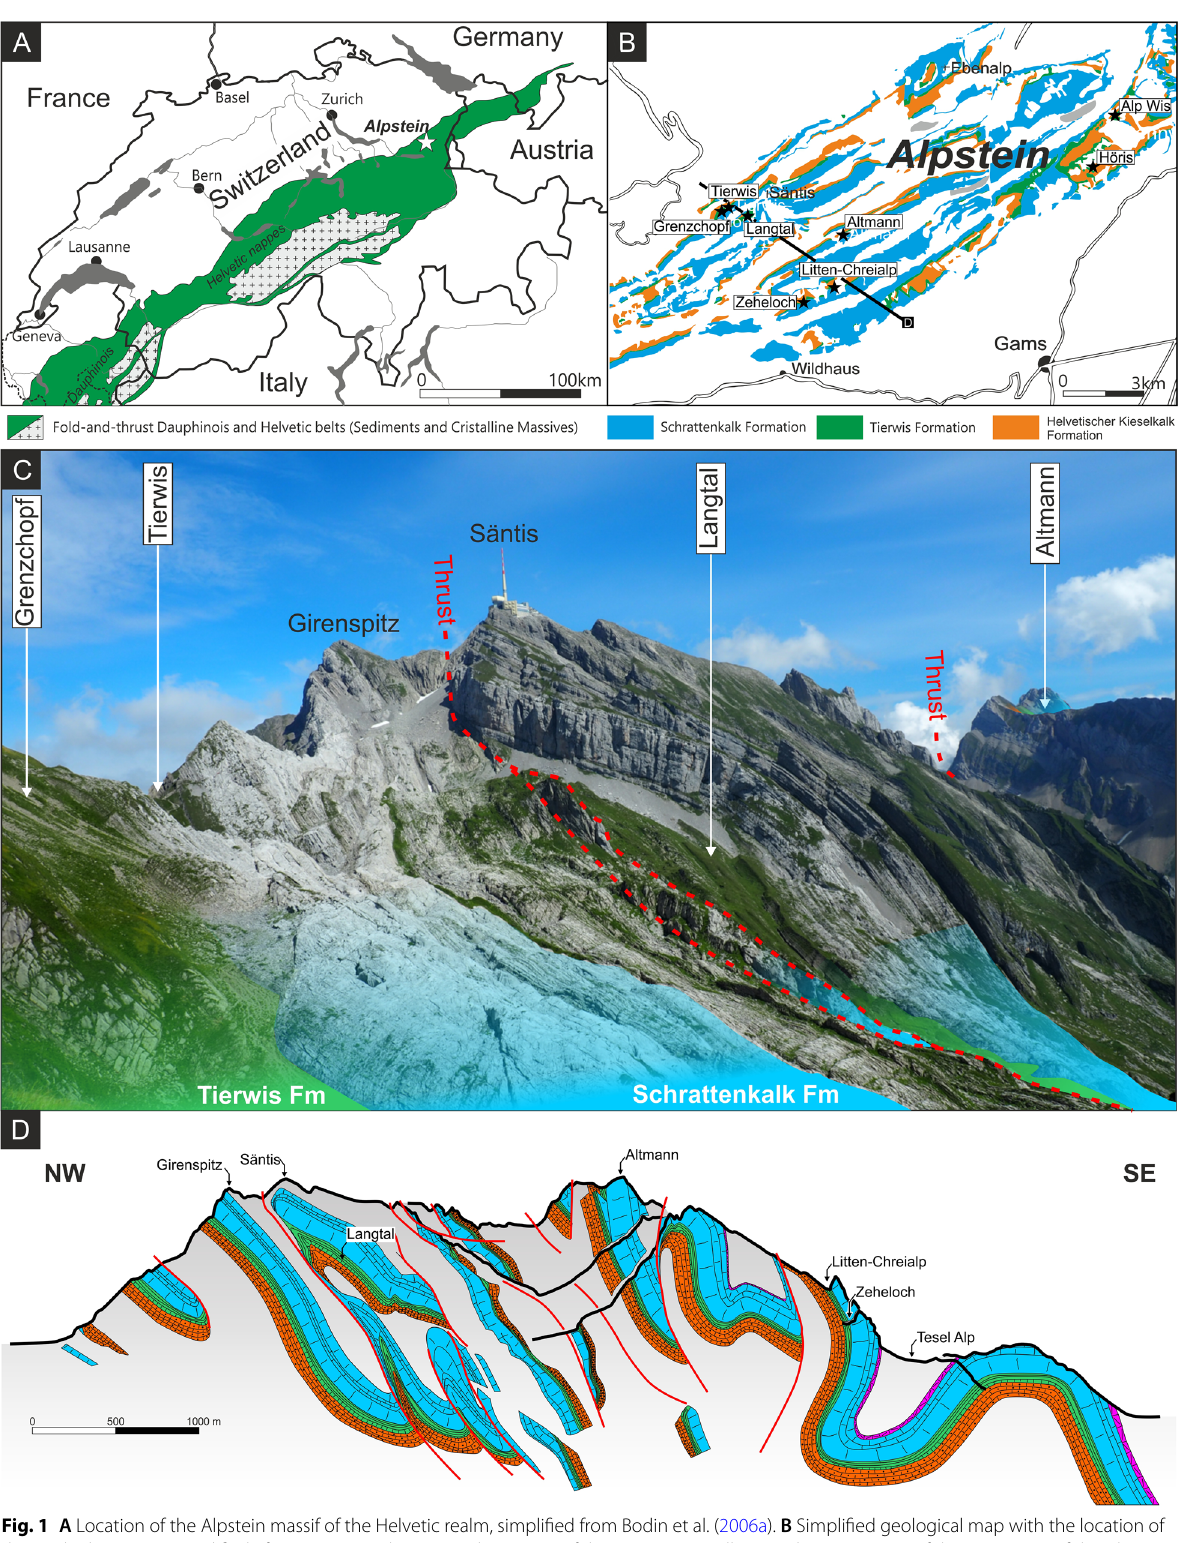
Fig. 1 A Location of the Alpstein massif of the Helvetic realm, simplified from Bodin et al. (2006a). B Simplified geological map with the location of the studied outcrops (modified after Eugster et al., 1982) with position of the cross-section illustrated in ( D ). C View of the Säntis part of the Alpstein massif with the position of some outcrops and the main thrust faults. D Geological cross-section of the Alpstein massif modified after Kempf (1966). The colours refer to ( B ), the S4-Gr unit is shown in